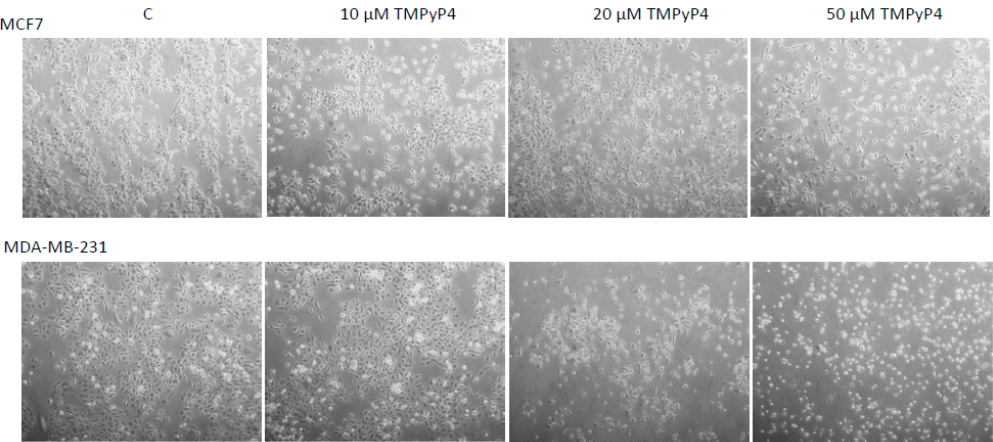
Figure 8. TMPyP4-mediated inhibition of adhesion properties of cancer cells. MCF7 and MDA-MB-231 cells were grown till reaching 70% confluence and exposed to 10, 20 or 50 µM TMPyP4 for 24 h. Then cells were trypsinized, and 5 × 10 5 cells were transferred to fresh dishes. Cells were analyzed under the phase contrast microscope and photographed after 15, 30, 60 min, 3 h and 18 h (Zeiss Axiovert microscope; magnification 100 × ). The most significant di ff erence was observed after 18 h. (All studied time intervals were shown in the Supplementary File 2). Typical result out of 3 replicates was